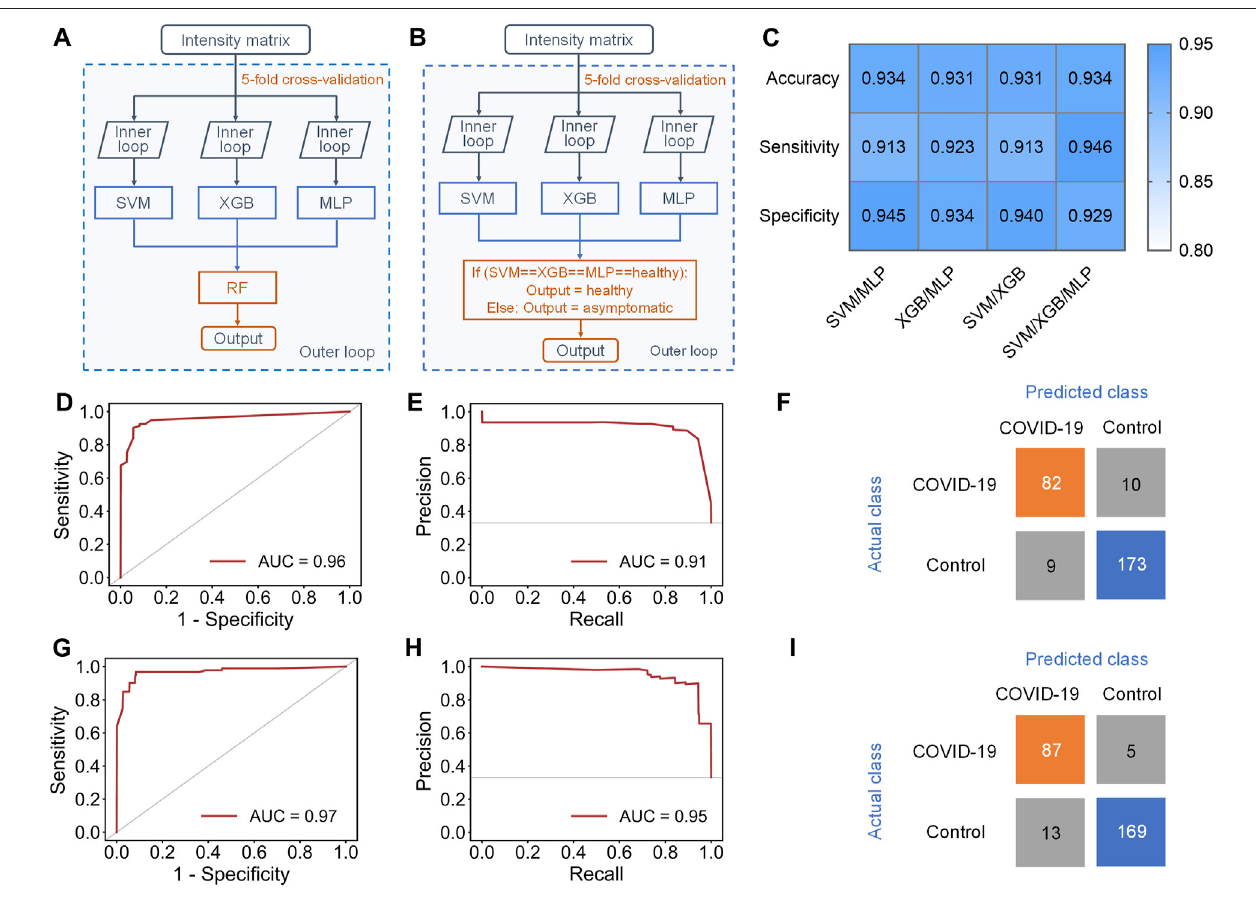
FIGURE4| Resultsofstackingandensemblelearningmethods. (A) Schematicwork fl owofthestackingmodelwith fi ve-foldnestedcross-validation,includingthe inner loop to tune the optimized hyperparameters of each separate classi fi er and the outer loop to evaluate the performance of the stacking model. (B) Schematic work fl ow of the new ensemble model with fi ve-fold nested cross-validation, including the inner loop to tune the optimized hyperparameters of each separate classi fi er andtheouterlooptoevaluatetheperformanceofthisensemblemodel. (C) Performanceindicatorsoffournewensemblemodelswithnovelvotingalgorithm. (D,E) , (D) ROCand (E) PRcurvesofthestackingmodelcontainingSVM,XGBandMLPinthe fi rstlevel. (F) Confusionmatrixofthestackingmodel. (G,H) , (G) ROCand (H) PR curve of the new ensemble model containing SVM, XGB and MLP in the fi rst level. (I) Confusion matrix of the ensemble model.